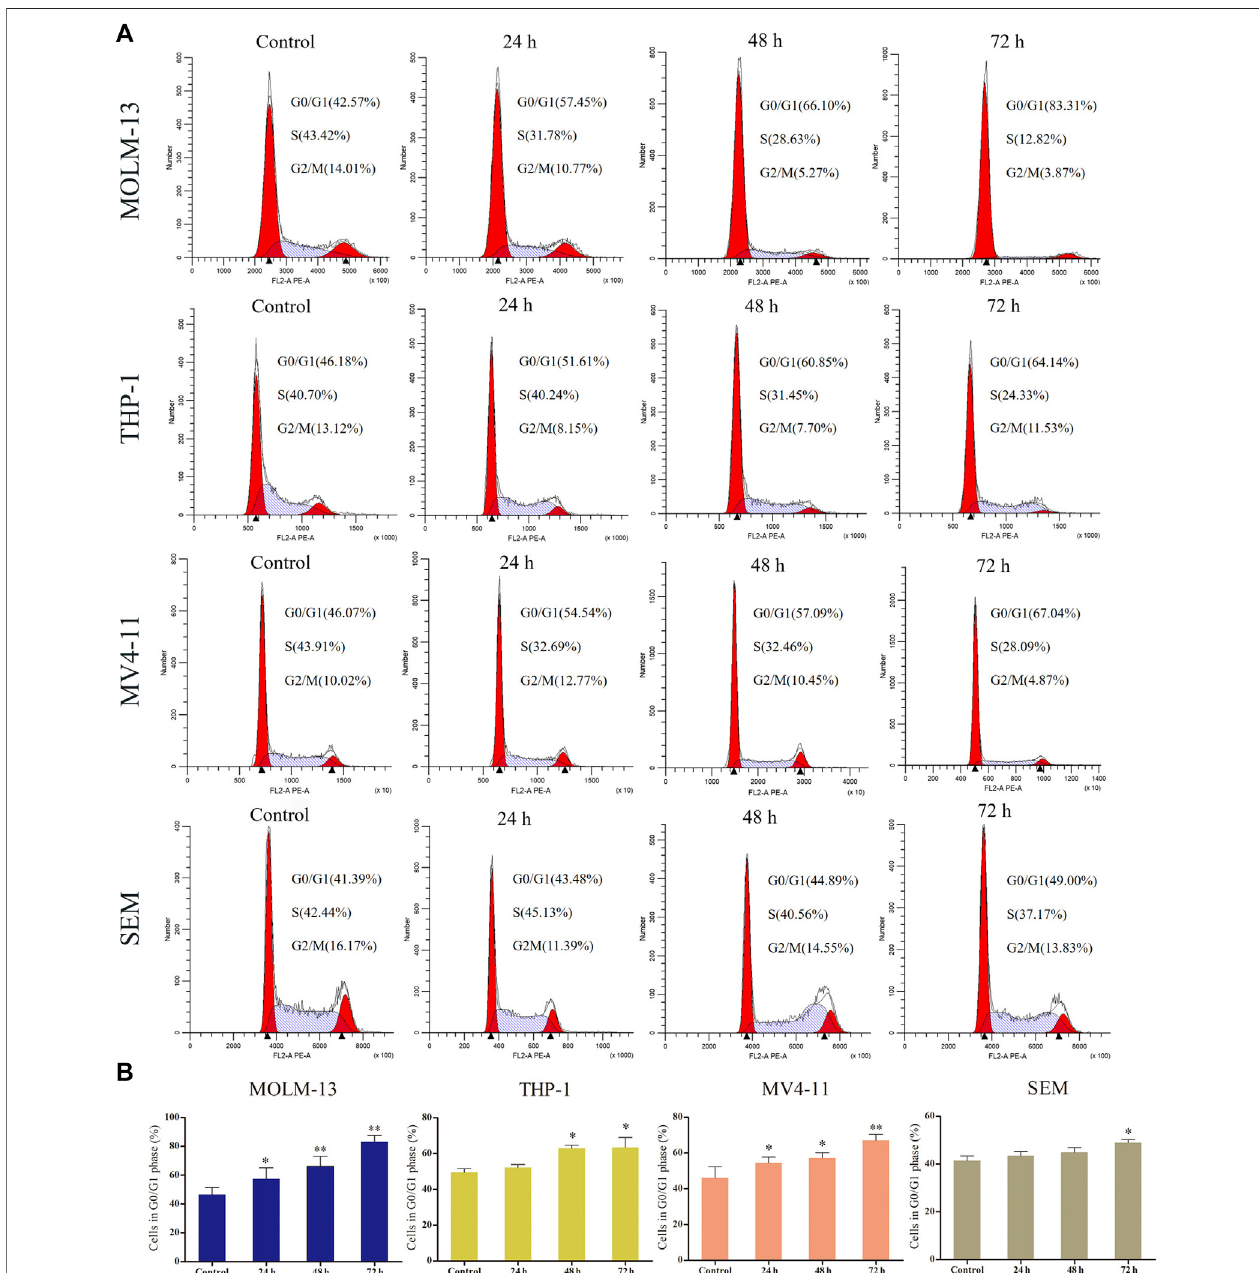
FIGURE 3 | I1 induces cell-cycle exit of MOLM-13, THP-1, MV4-11 and SEM cells. (A) MOLM-13, THP-1, MV4-11 and SEM cells were treated with I1 at the concentrations of 1, 0.7, 0.5 or 0.7 μ M, respectively for 24, 48 or 72 h, then stained with PI, and detected using fl ow cytometry. (B) Graph bars show the percentage of cells at G0/G1 phase. (* p < 0.05, ** p < 0.01). The cell cycle analysis was performed three